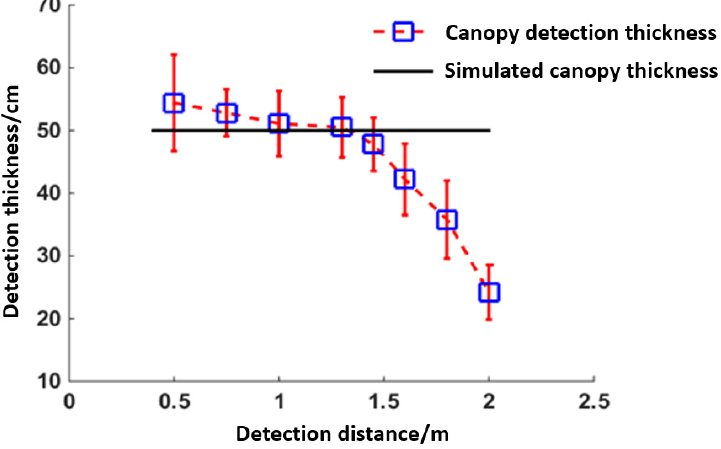
Figure 5. Canopy detection thickness curves at different detection distances.